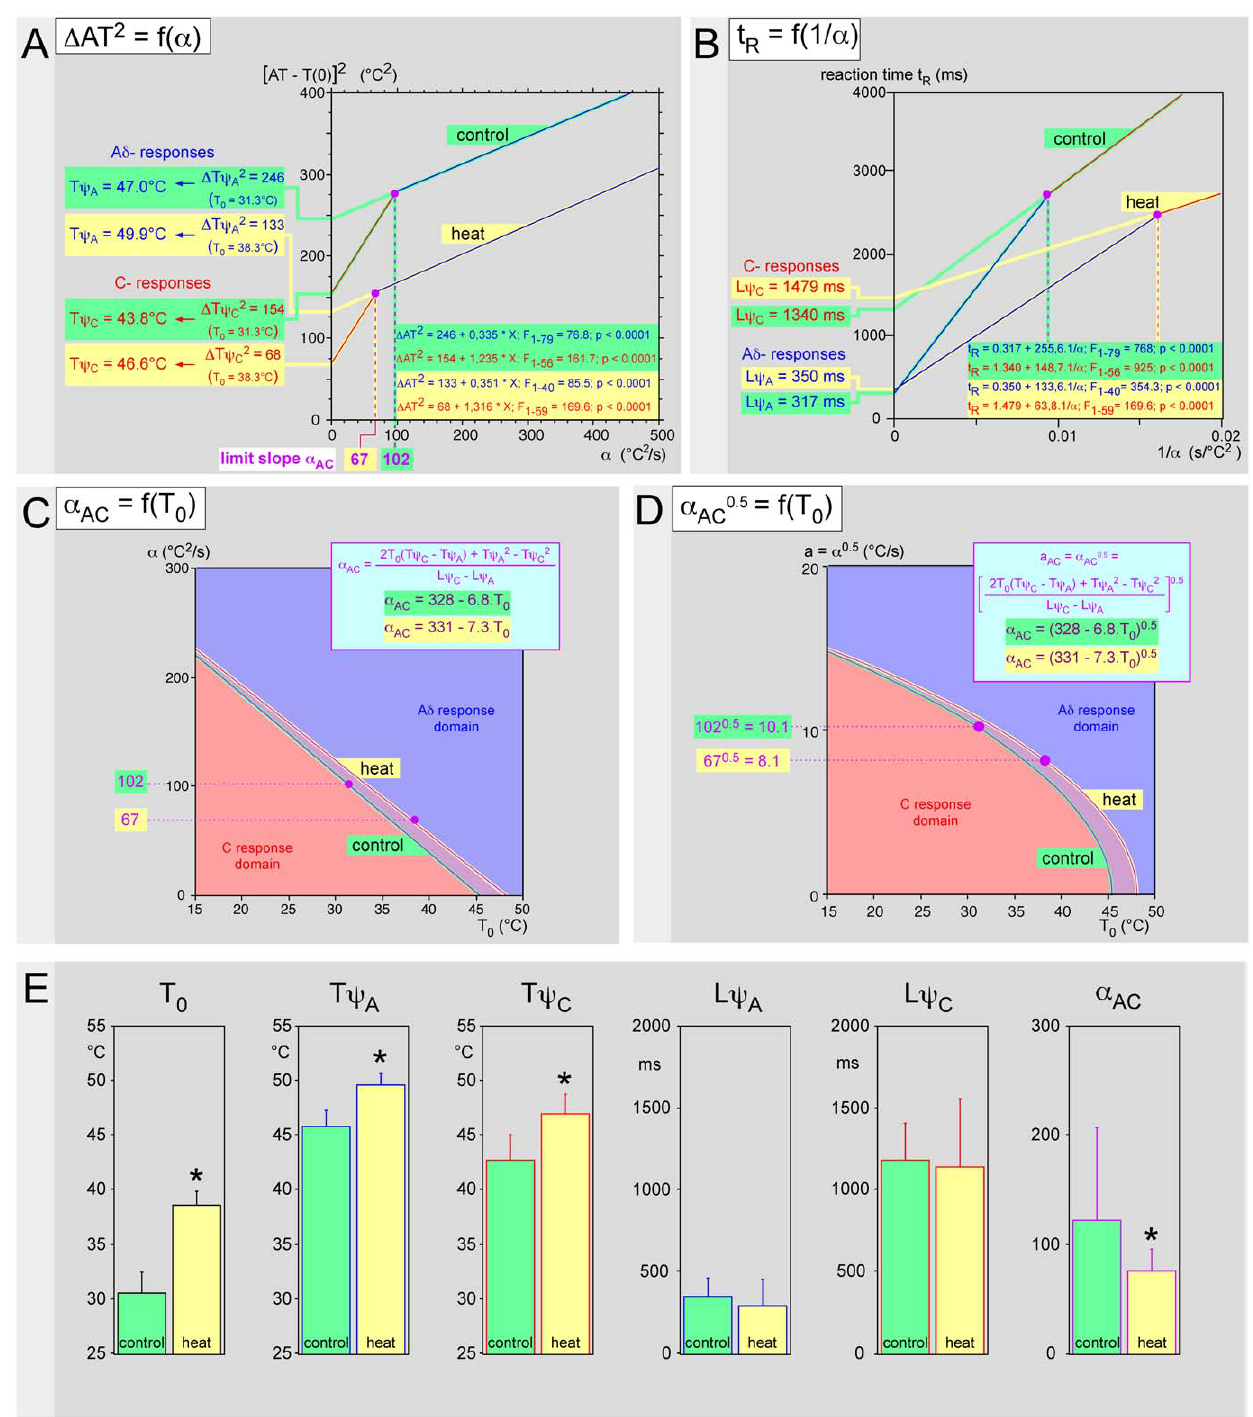
Figure 9. Effects of heating on the psychophysical variables. The whole dorsal surface of the hand was warmed to 38 u C by means of an infrared lamp. - A Individual example. Relationship D AT 2 =(AT 2 T 0 ) 2 =f( a ) which allowed one to determine the psychophysical thresholds T y . A dotted purple line marks the limit slopes a AC that delineate the A d - from the C-response domains. The shift of the straight lines D AT 2 =f( a ) during heating is misleading because the base temperatures were very different. The heat indeed elicited an increase of T y C and T y A thresholds by about 3 u C. - B Corresponding relationship t R =f(1/ a ) which allowed one to determine the psychophysical latencies L y . Note the variations of the slopes of the straight lines t R =f(1/ a ) following heating without any modification of the intercept with the ordinate, which means that the psychophysical latencies were not modified by heating. - C Curves in the plane [T 0 , a ] which delimit the domains for obtaining responses triggered by A d - and C- fibers, respectively (see Fig. 4); the purple full circles correspond to the values determined experimentally. Curves are calculated from the T y C T y A , L y C and L y A values, all determined experimentally as the point of coordinates [T 0 , a AC ]. One can see a shift of the respective domains of the responses elicited by A d - and C-fibers to the advantage of the latter. - D Identical results shown in the plane [T 0 , a AC0.5 ]. E. Overall mean results regarding physical (T 0 ) and psychophysical (T y A , T y C , L y A , L y C and a AC ) variables (*=p , 0.05; Wilcoxon-Mann-Whitney test).